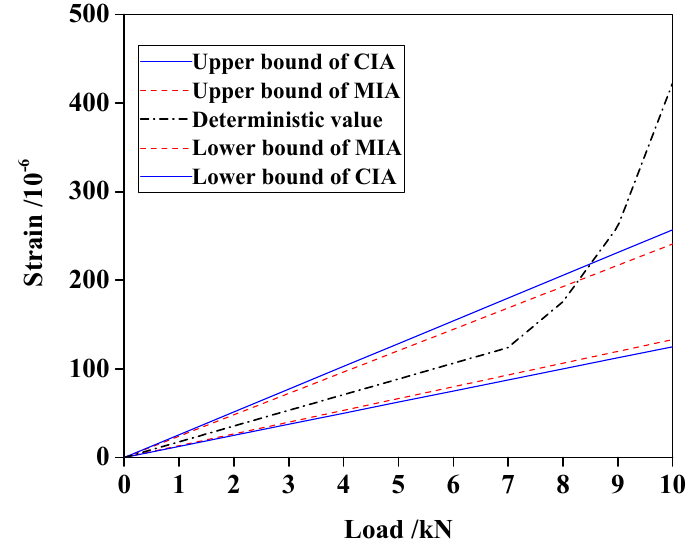
Figure 2. Strain envelopes of the numerical beam.